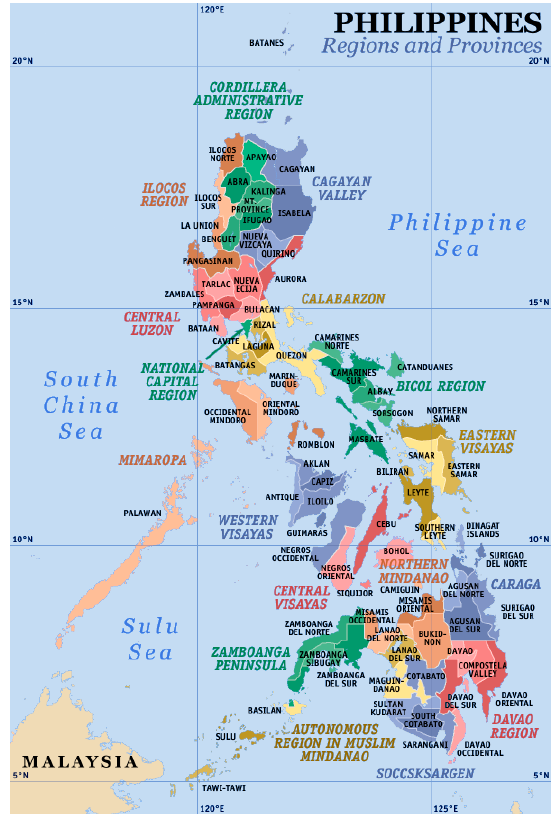
Figure 1. Map depicting the Philippines regions and provinces. © Eugene Alvin Villar, 2003